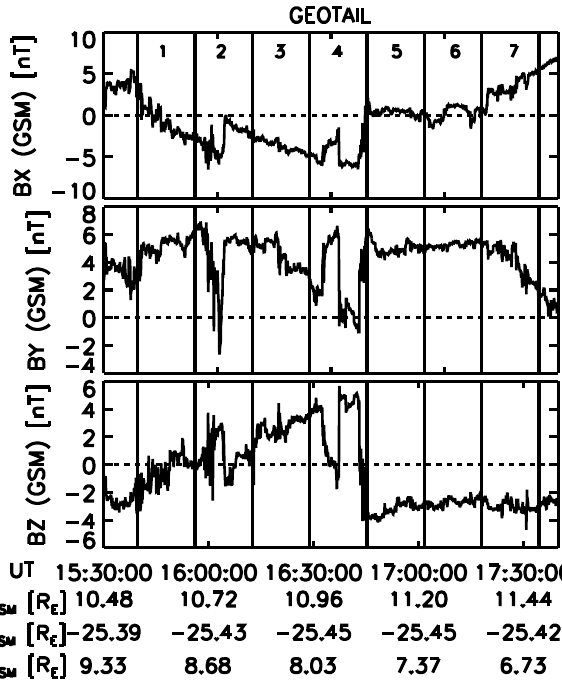
Fig. 8. The Geotail solar wind magnetic field. Time intervals cor- responding to the analyzed Polar data segments are marked with vertical